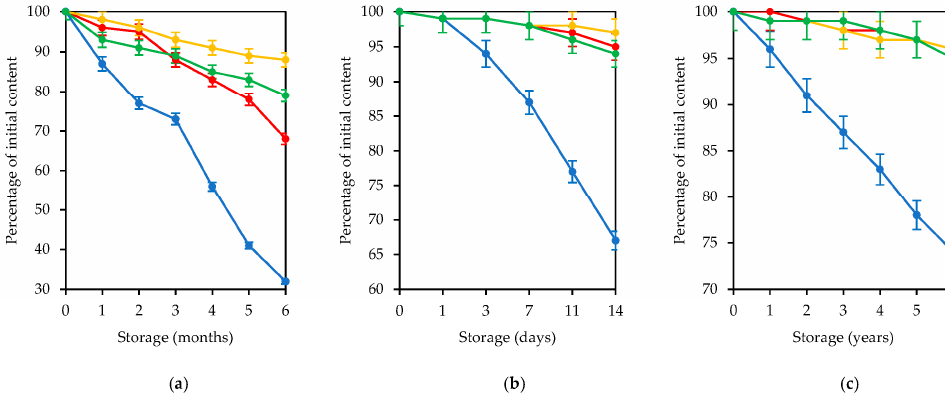
Figure 3. Changes in coumarin content in lovage roots during storage of fresh roots at 1 ◦ C ( a ) and at 20 ◦ C ( b ) and dried roots at 10 ◦ C ( c ). Lines: apterin (blue), xanthotoxin (red), isopimpinellin (yellow), and pimpinellin (green).